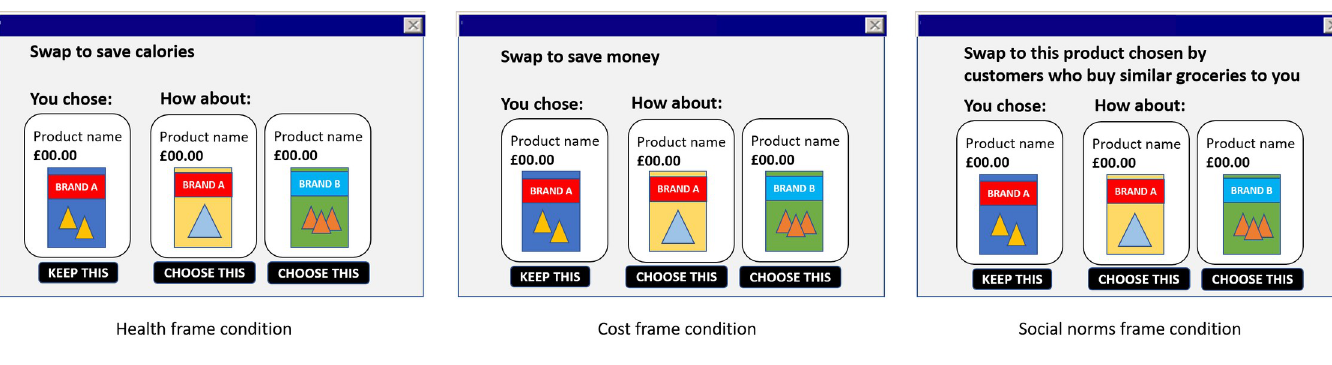
Fig 1. Mock-up of swap offer pop-ups with message